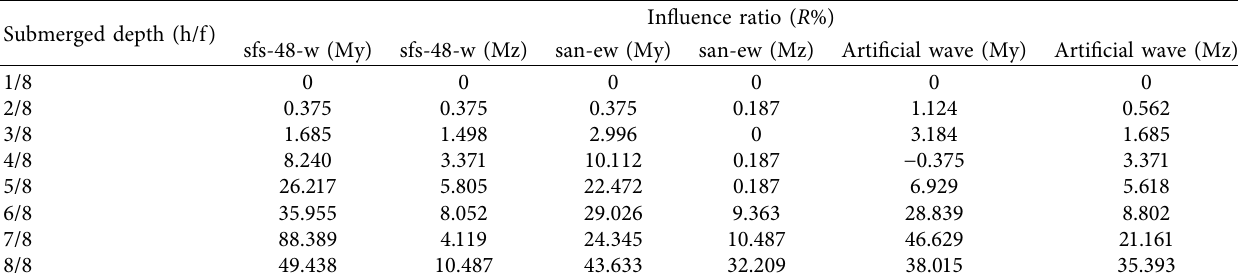
Figure 6: Te time history of My at arch foot under the action of seismic wave sfs-48-w in the absence of water. Table 2: Te relation of R and submerged depth at arch foot.